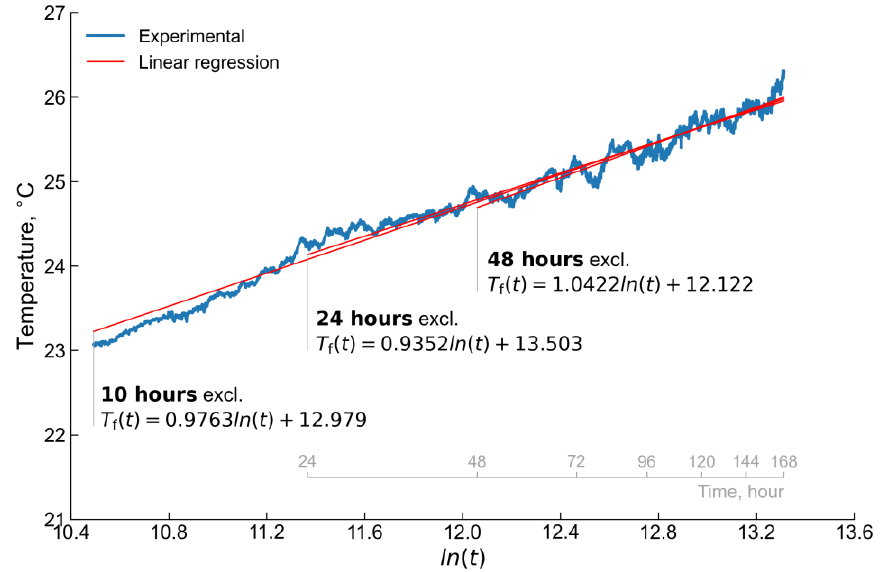
Figure 8. Regression line for temperature vs. time (full time, 7 days).